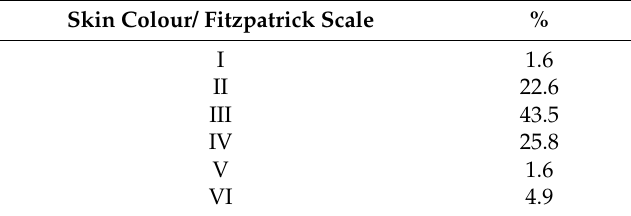
Table 4. Analysis of the skin type of the pilot study subjects, based on Fitzpatrick scale.